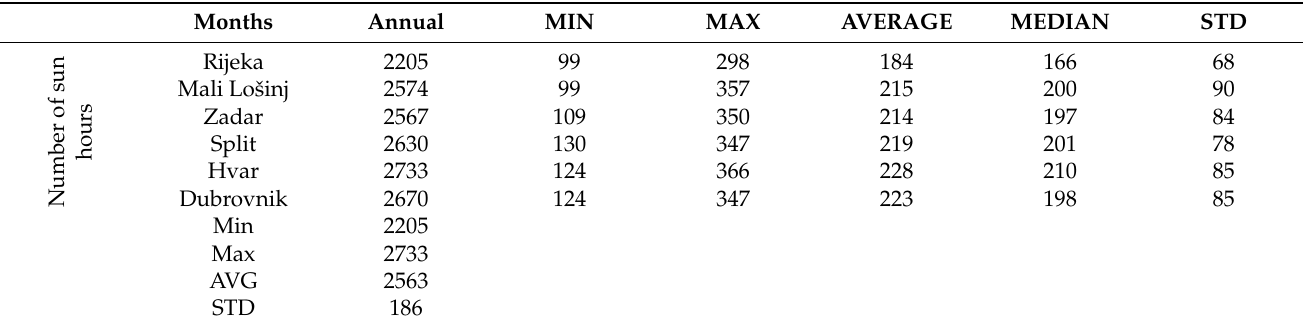
Figure 7. Graphical presentations of a variable number of sun hours for six locations at the Adriatic Sea. Table 5. Annual statistical measures of the number of sun hours for six locations.